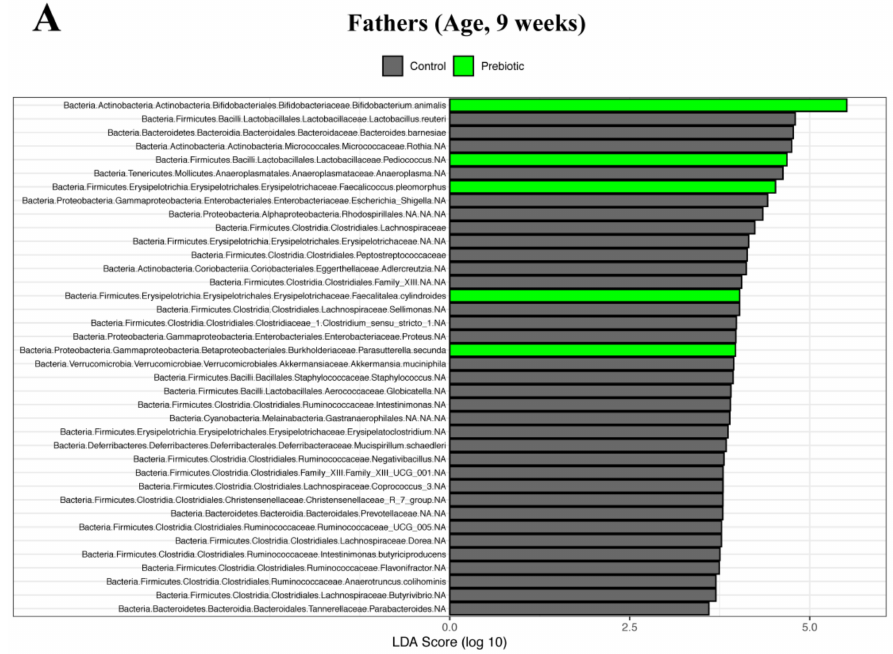
Figure 3. Fecal microbiota comparisons of fathers fed prebiotic or control diet and the intergenerational similarities in male and female offspring. Beta diversity of ( A ) paternal at 12 weeks of age, ( B ) male offspring and ( C ) female offspring at 15 weeks of age, calculated with principal coordinates analysis (PCoA) using a Bray–Curtis distance matrix. Cecal short chain fatty acids in: ( D ) fathers, ( E ) adult male offspring and ( F ) adult female offspring at euthanasia. Values are means ± SEM, n = 8–13 ( p <